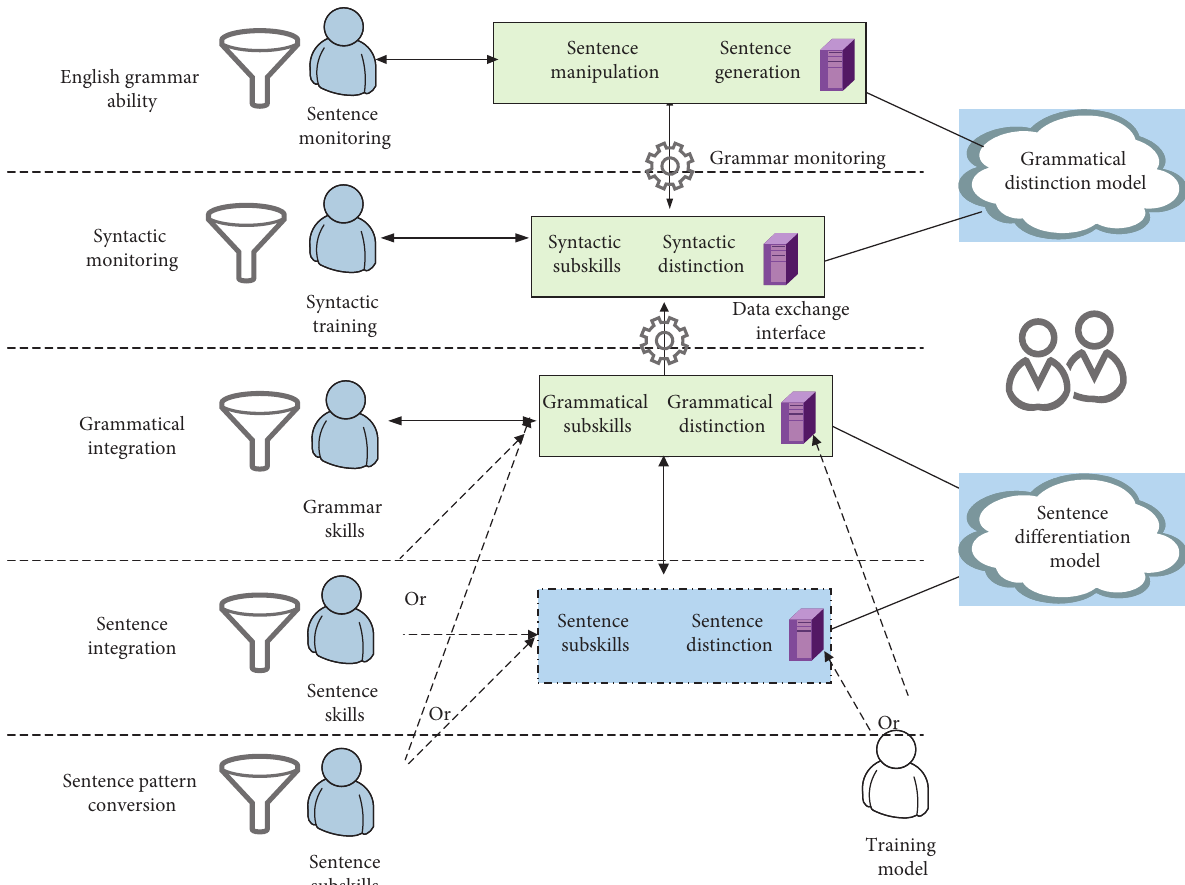
Figure 1: Network model of English grammar discriminating ability training, grammar skills, and grammar subskills discriminating Table 1: General description of the design framework of the English Grammar discriminating ability training scale. Measuring the